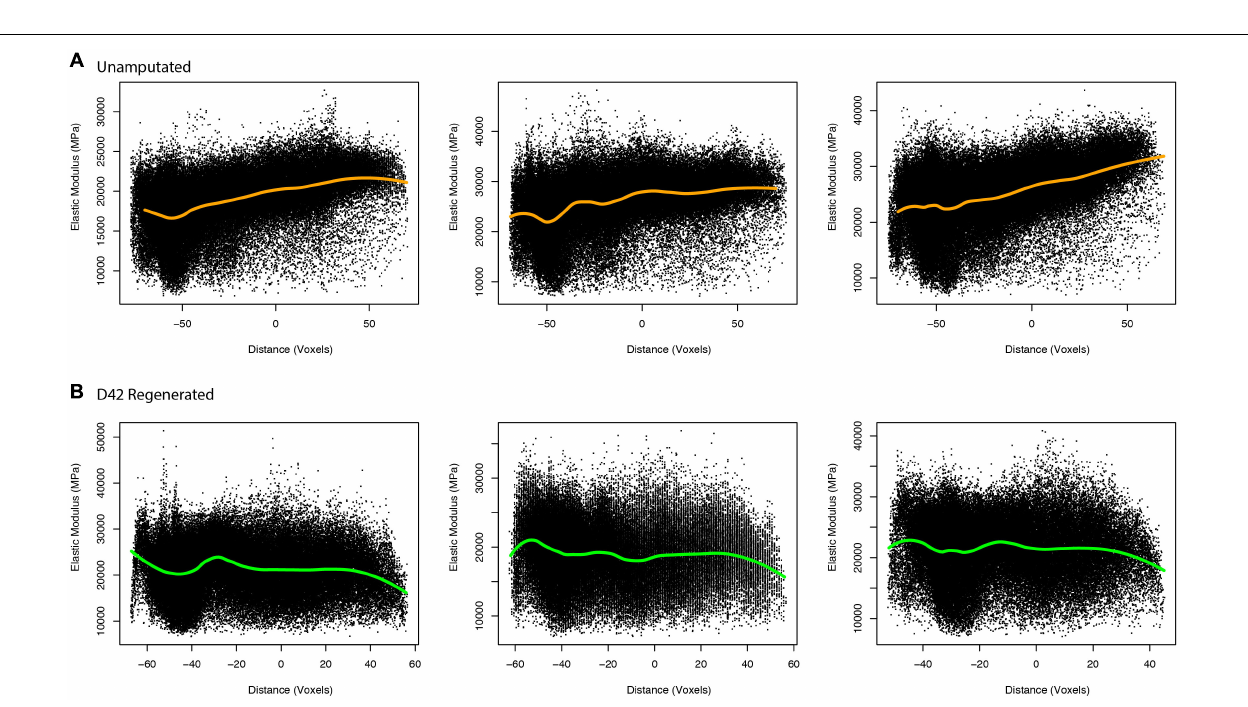
Frontiers in Cell and Developmental Biology |